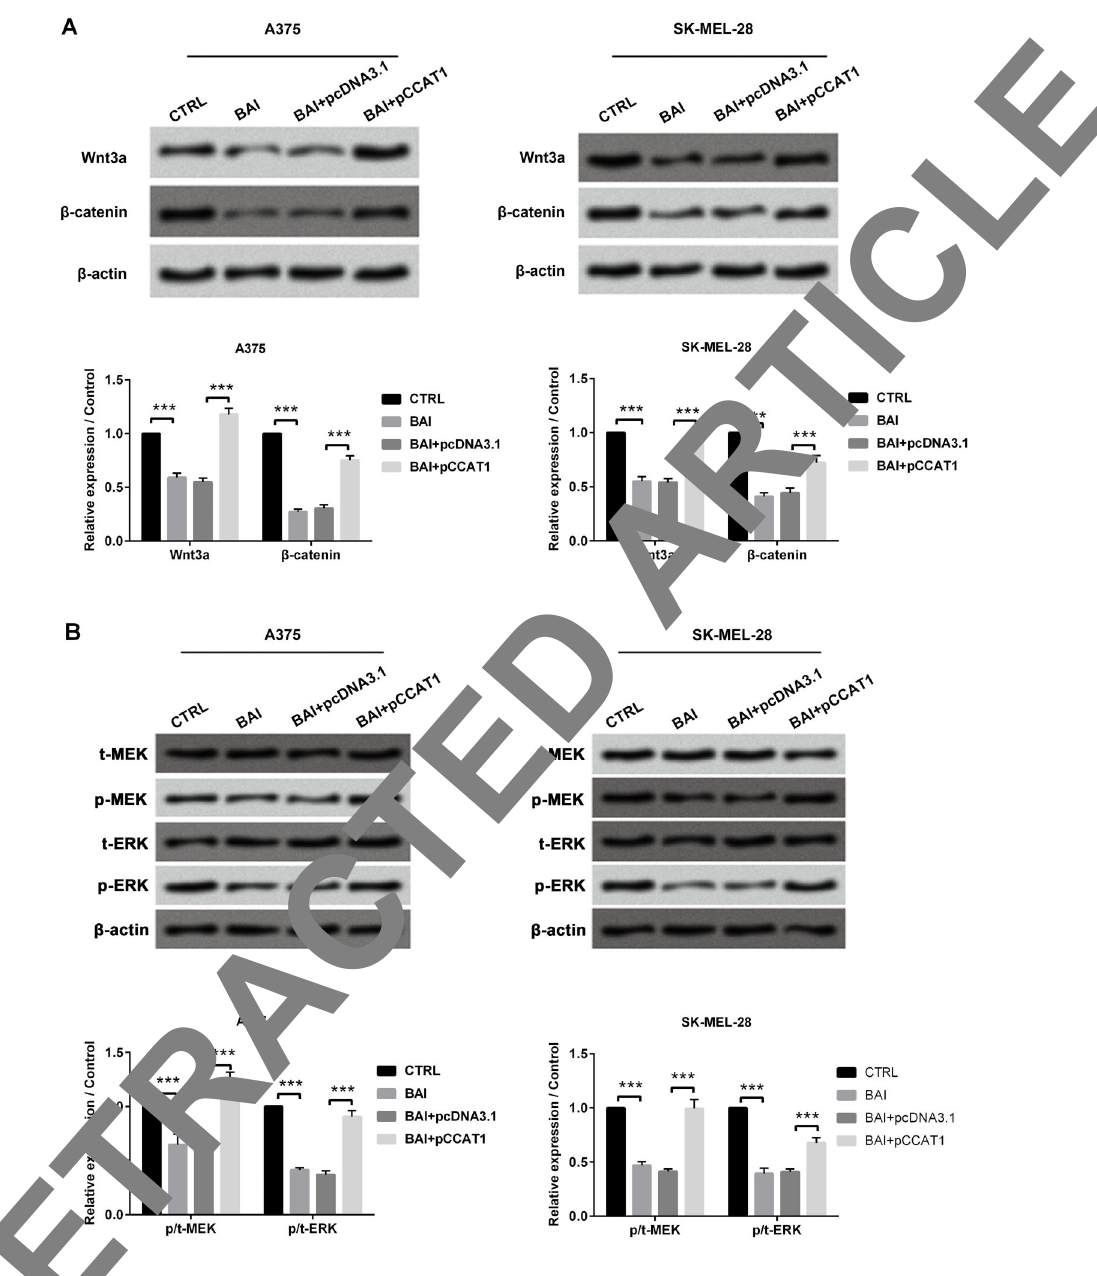
Figure 6. Baicalein (BAI) suppressed CCAT1 to block Wnt/ b -catenin and MEK/ERK signaling pathway. A , The expression of Wnt3a and b -catenin and, B , of p-MEK, p-ERK, t-MEK, and t-ERK were examined by western blot. The relative expression of proteins was normalized by b -actin. Data are reported as mean ± SD. ***P o 0.001 (ANOVA). CTRL: exogenous CCAT1 (P o 0.001, Figure 6A). Similarly, the protein levels of p-MEK and p-ERK were also suppressed by BAI (P o 0.001, Figure 6B). The results indicated that BAI blocked Wnt/ b -catenin or MEK/ERK pathways by negatively regulating CCAT1.